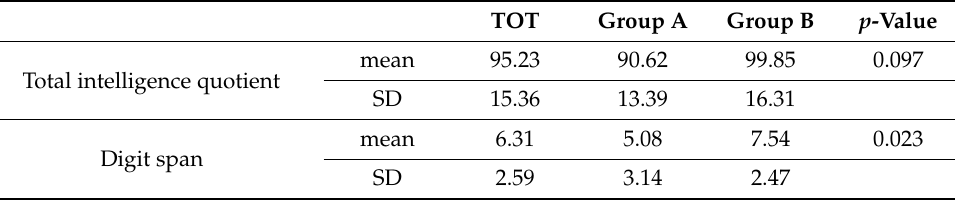
Table 2. Results of the WAIS-R/WISC-IV scales in the patients of the study. TOT Group A Group B p -Value Total intelligence